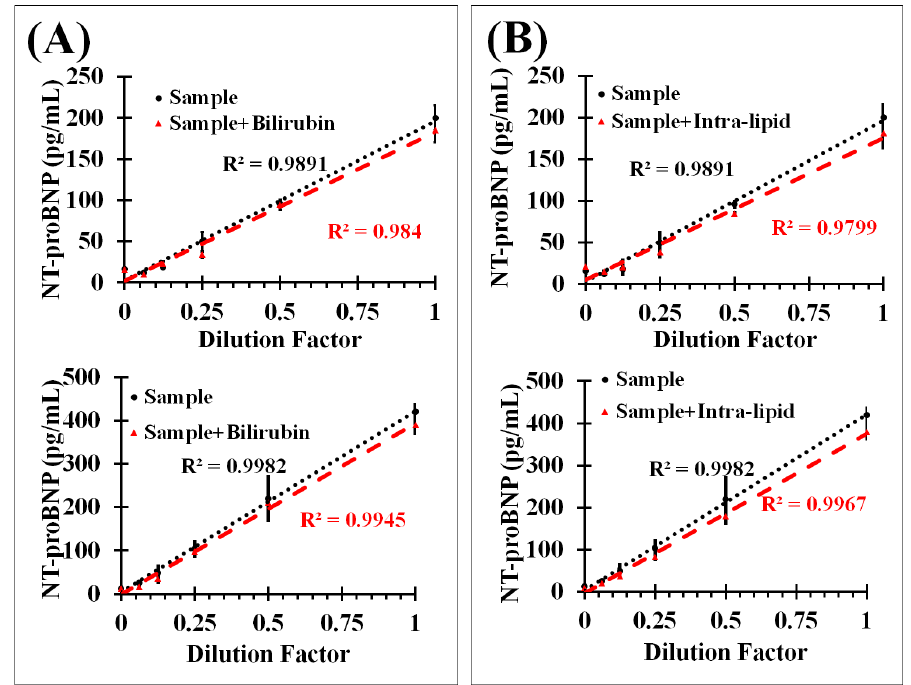
Figure 3. Determination of interference of ( A ) Bilirubin (0.2 mg/mL), ( B ) Intra-lipid (0.2%) emulsion (Plasma samples containing 200 pg/mL and 420 pg/mL of NT-proBNP arranged from top to bottom, respectively).